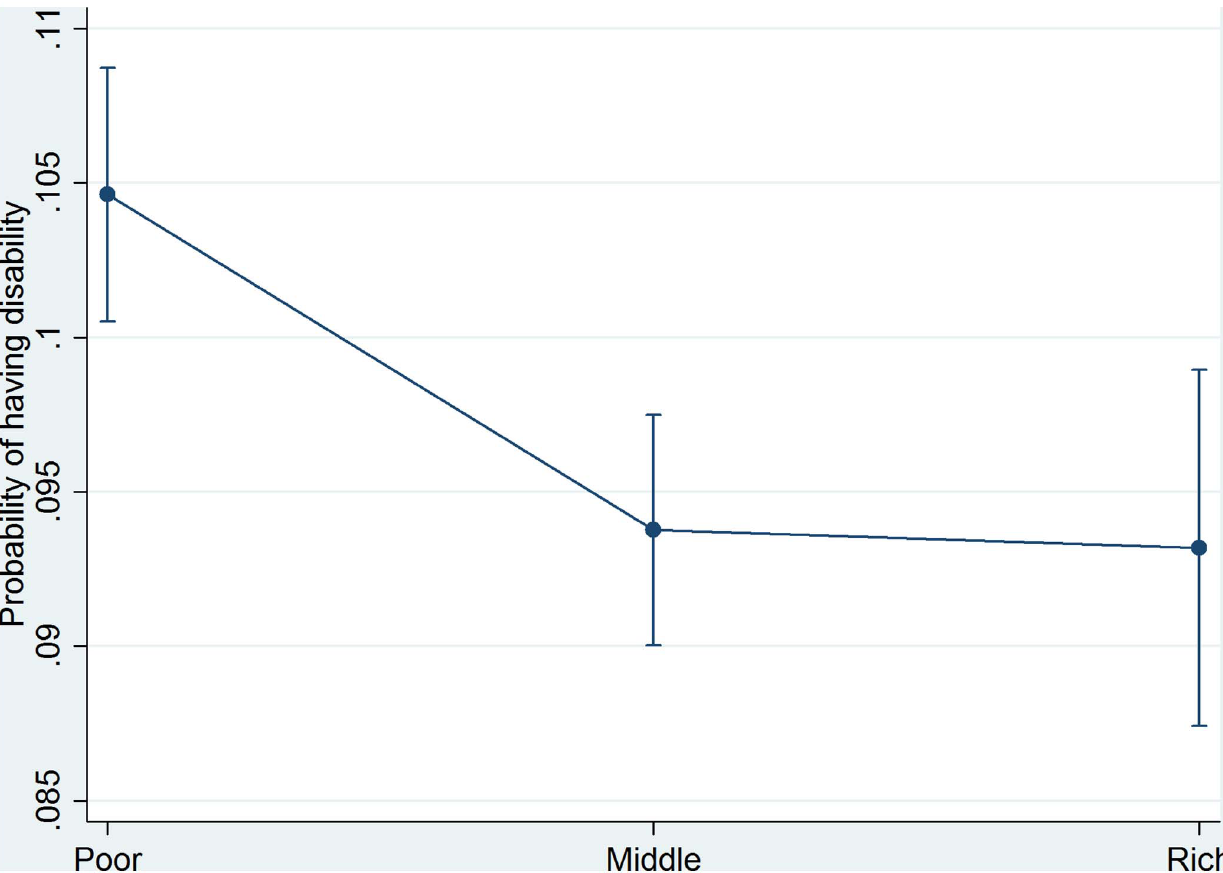
Figure 1. Predicted probabilities of disability by wealth index in Bangladesh.